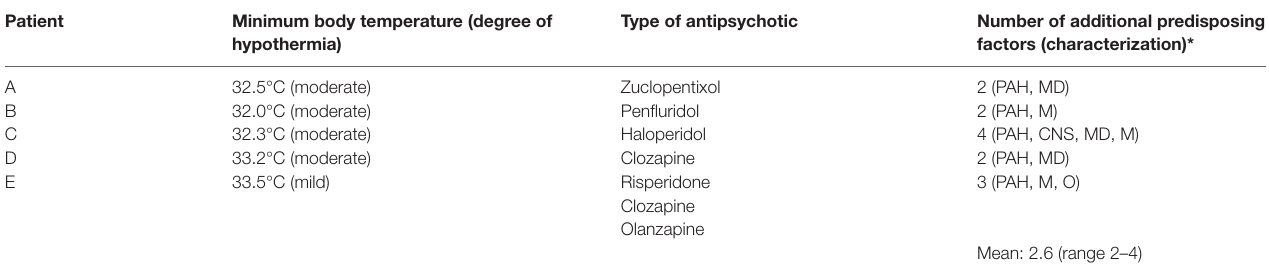
TABLE 1 | Degrees of hypothermia and analysis of predisposing